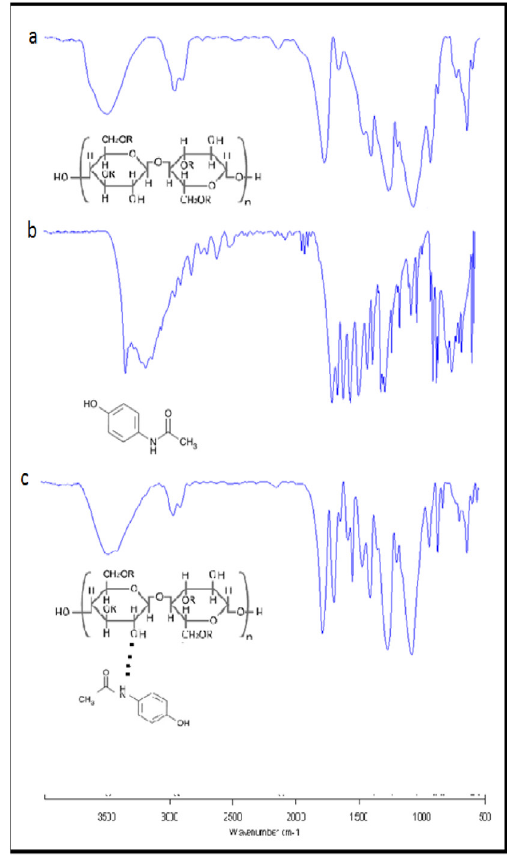
Fig.3. XRD pattern of (a) pure acetaminophen and (b) drug-containing NFC.